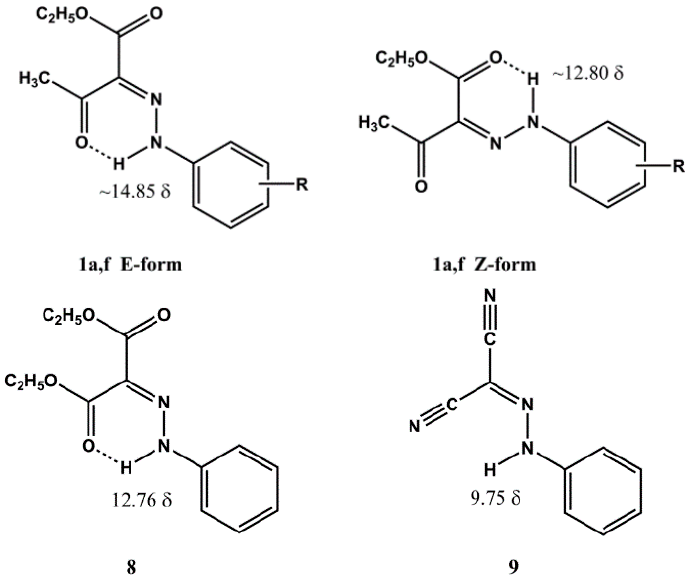
Figure 2. Reported NH chemical shift values of the geometrical structures of compounds 1a , f , ethyl (2-phenylhydrazinylidene)mesoxalate ( 8 ) and 2 - (2-phenylhydrazinylidene)propanedinitrile ( 9 ).